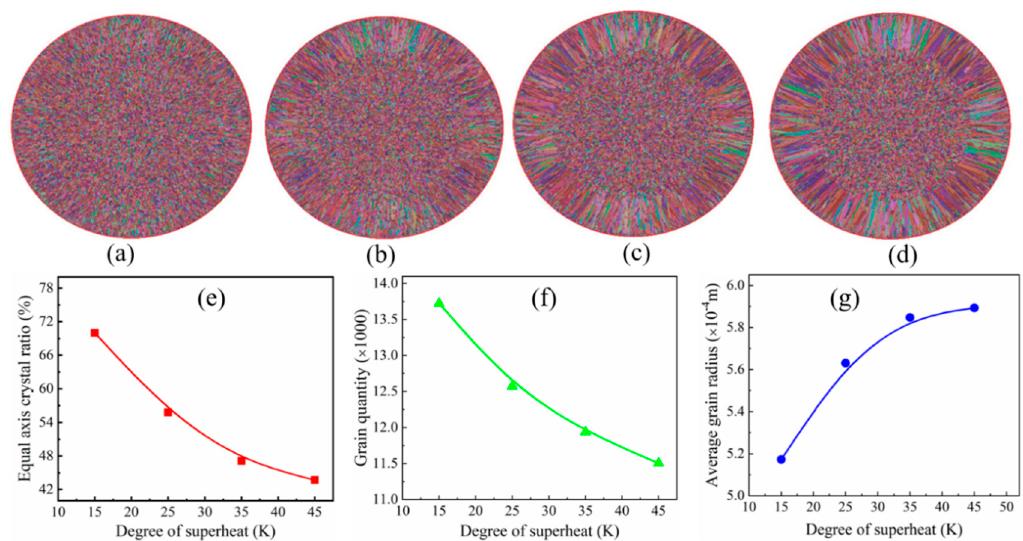
Figure 5. Influence of the superheat degree on the solidification structure ( a – d ): solidification structure morphology at superheat degrees of 15, 25, 35, and 45 K, respectively; ( e – g ): changes in equiaxed crystal ratio, grain number, and average grain radius with the superheat degree, respectively.